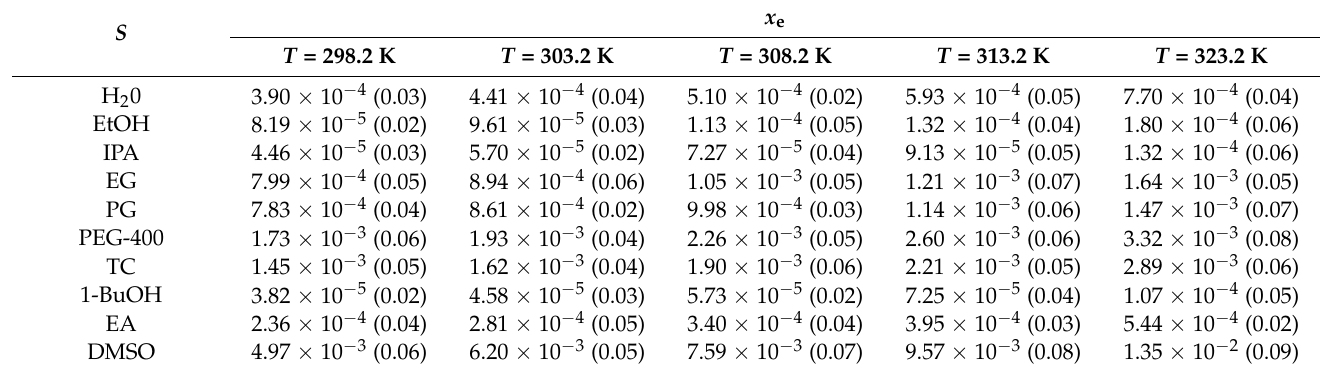
Table 1. Experimental solubilities ( x e ) of TMZ in mole fraction in different solvents ( S ) at “ T = 298.2 K to 323.2 K” and “ p = 0.1 MPa” a (values in parentheses are standard